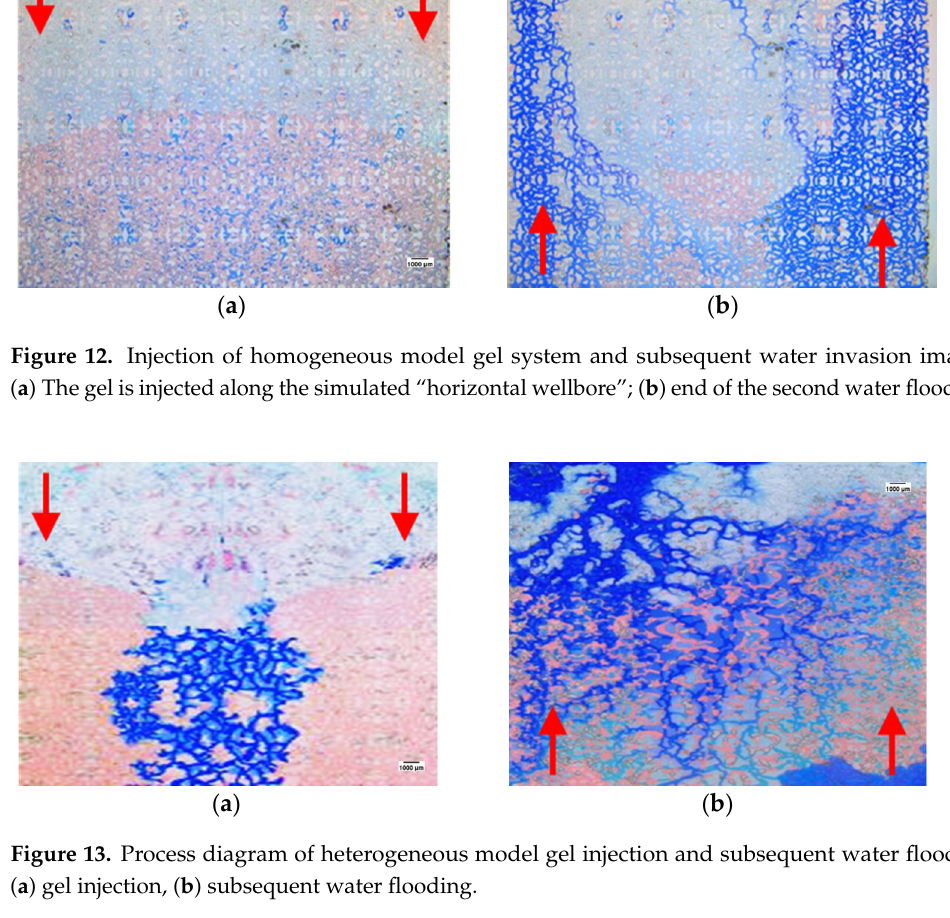
Figure 12. Injection of homogeneous model gel system and subsequent water invasion images. ( a )